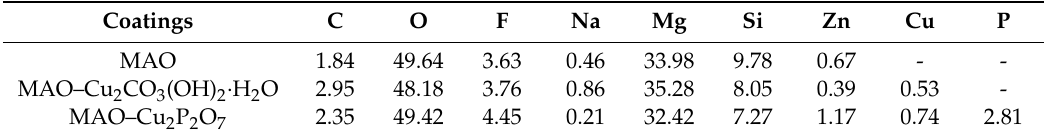
Figure 2. Surface morphologies of three MAO coatings on AZ91D magnesium alloy, ( a ) and ( b ) MAO, ( c ) and ( d ) MAO–Cu 2 CO 3 (OH) 2 · H 2 O and ( e ) and ( f ) MAO–Cu 2 P 2 O 7 . Table 2. EDS results of the MAO, MAO–Cu 2 CO 3 (OH) 2 · H 2 O and MAO–Cu 2 P 2 O 7 coatings on AZ91D magnesium alloy (at. %).